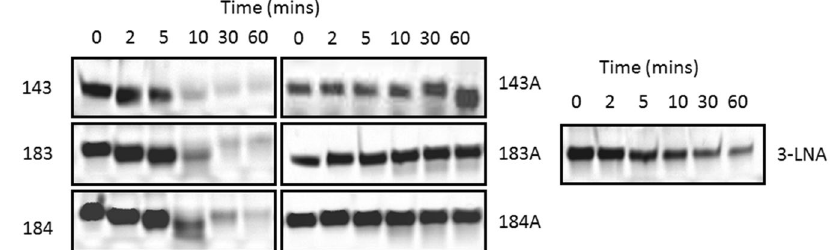
Figure 5. Phosphodiesterase degradation analysis of DNAzymes that showed high efficacy in the cleavage of ITGA4 RNA in vitro and knockdown of ITGA4 RNA in fibroblasts. The gel images were cropped for better overview. The original images are shown in Figure S4 (Supplementary